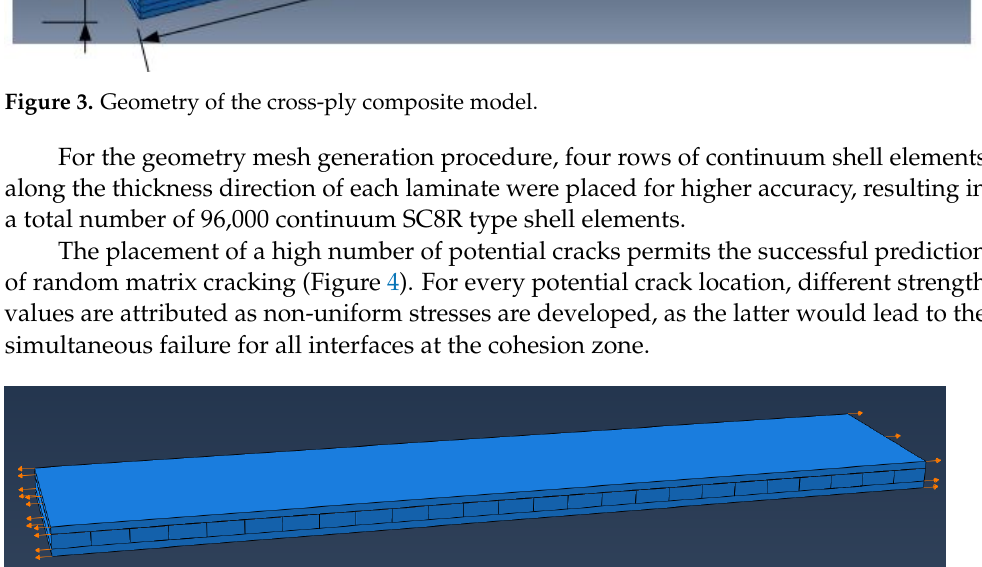
Figure 4. Modeling of the possible transverse cracks with a cohesive